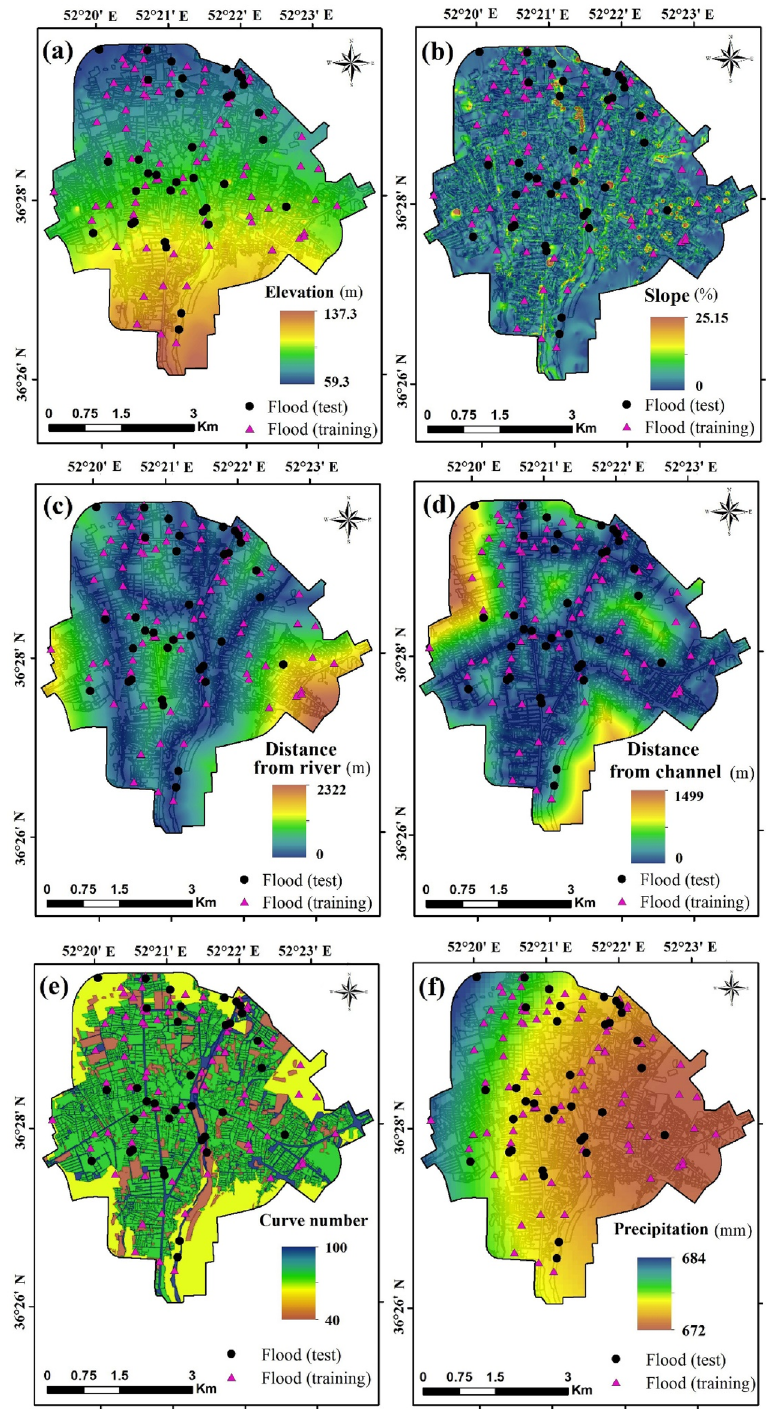
Desktop 10.7.1, https ://deskt op.arcgi